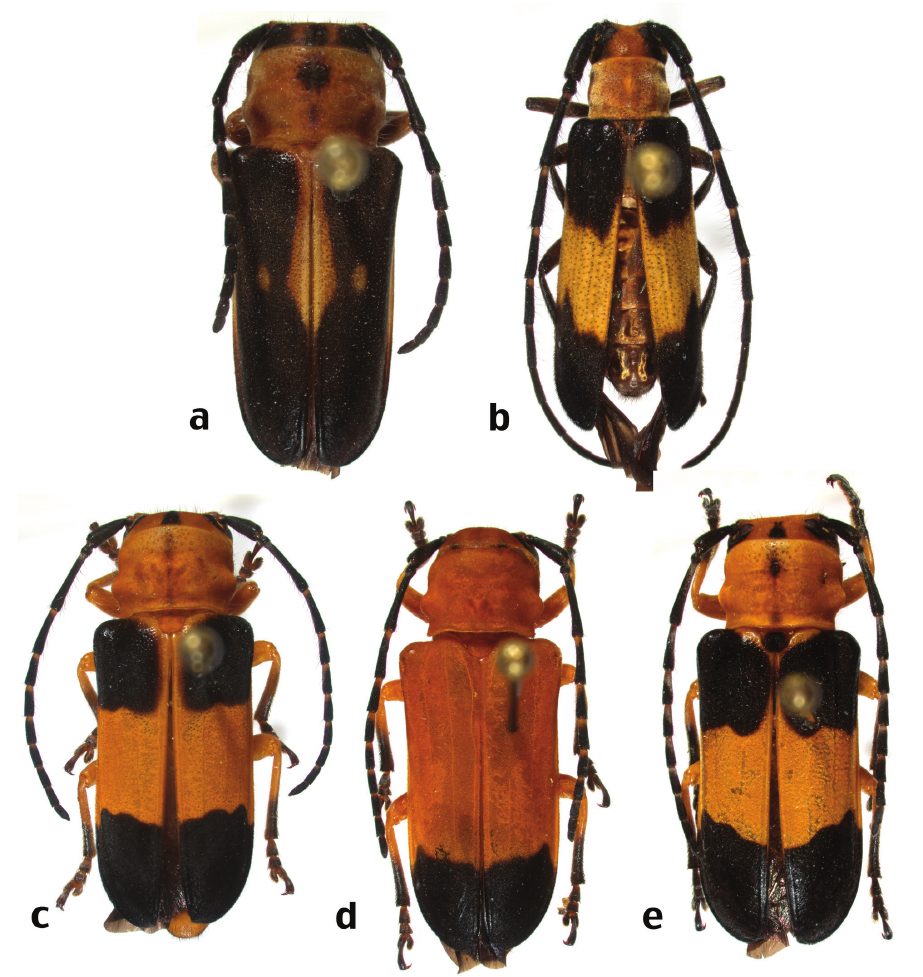
Figure 5. New species of Hispaniolan Hemilophini (not to scale): a Calocosmus punctatus Lingafelter, sp. n., holotype b Calocosmus rawlinsi Lingafelter, sp. n., holotype c Calocosmus robustus Lingafelter, sp. n., holo- type d Calocosmus robustus Lingafelter, sp. n., paratype e Calocosmus robustus Lingafelter, sp. n., yellowish-orange scale-like pubescence, however not obscuring integument. Pronotum with overall orange appearance with ovate, black divided macula at middle and slightly darker patches anterior to elytral base. Pronotum with distinct, large, non-contiguous punctures, without dorsal calli or tubercles, but with swelling posterior to middle. Pro- notum a little less than one-fourth length of body. Prosternum inconspicuously pubes- cent with short, appressed, orange or yellow setae. Prosternal process broadly expanded at apex, closing procoxal cavities posteriorly. Elytron with distinct, dense punctures throughout except on extreme apex, covered in dense, short pubescence, but not ob- scuring surface. Elytral color black, except for orange pattern as follows: base around